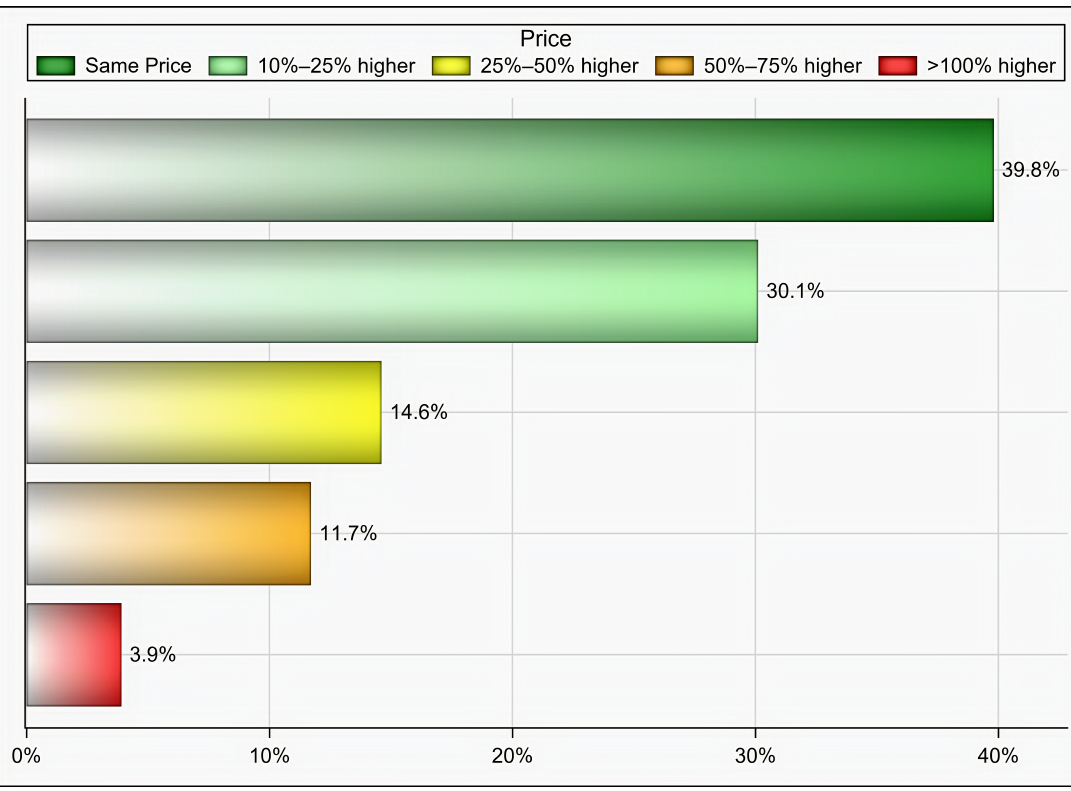
Figure 3. The impact of COVID-19 on prices of drugs in short supply based on participants’ responses.